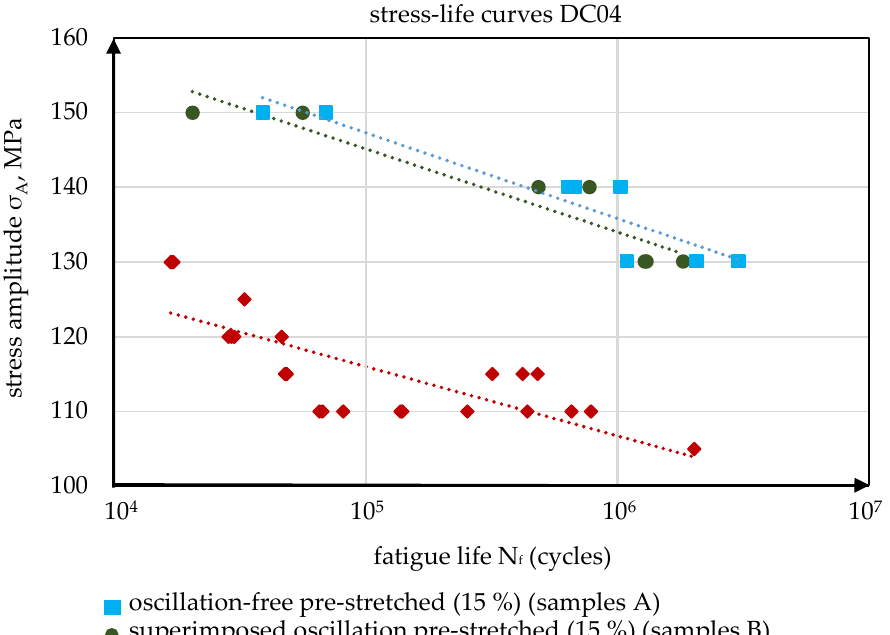
Figure 2. Stress-life curves for flat-tensile test specimens made out of DC04.